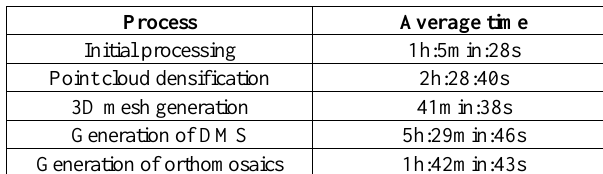
Table 4. Processing times (02-feb-18)